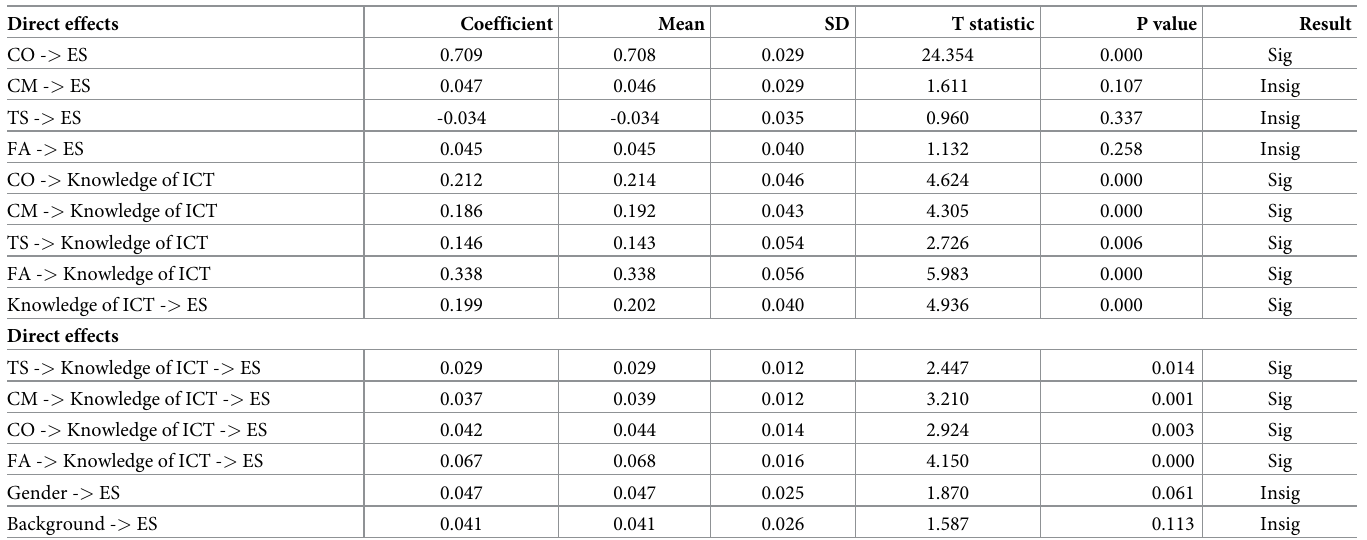
Table 5. Direct and indirect